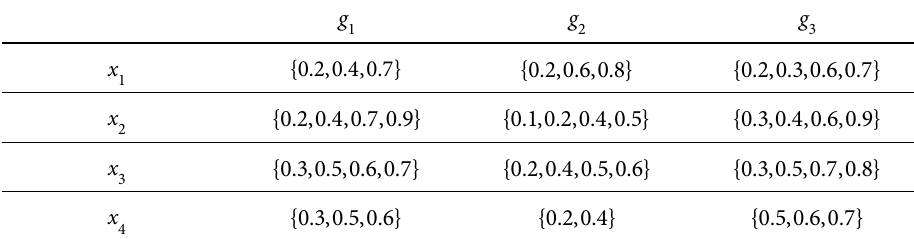
Table 2. The hesitant fuzzy decision matrix D